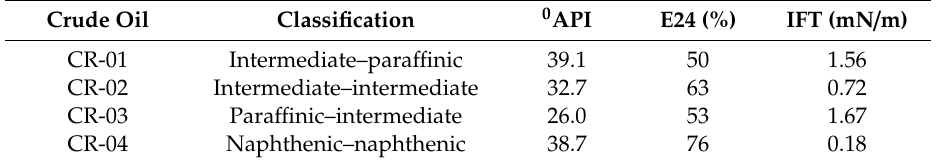
Table 4. Biosurfactant emulsification activity and interfacial tension (IFT) value of H. meridiana BK-AB4. Crude